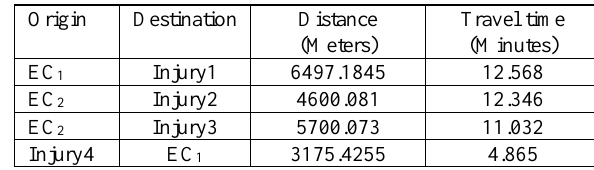
Table 3. Details of updated ambulances routes during five